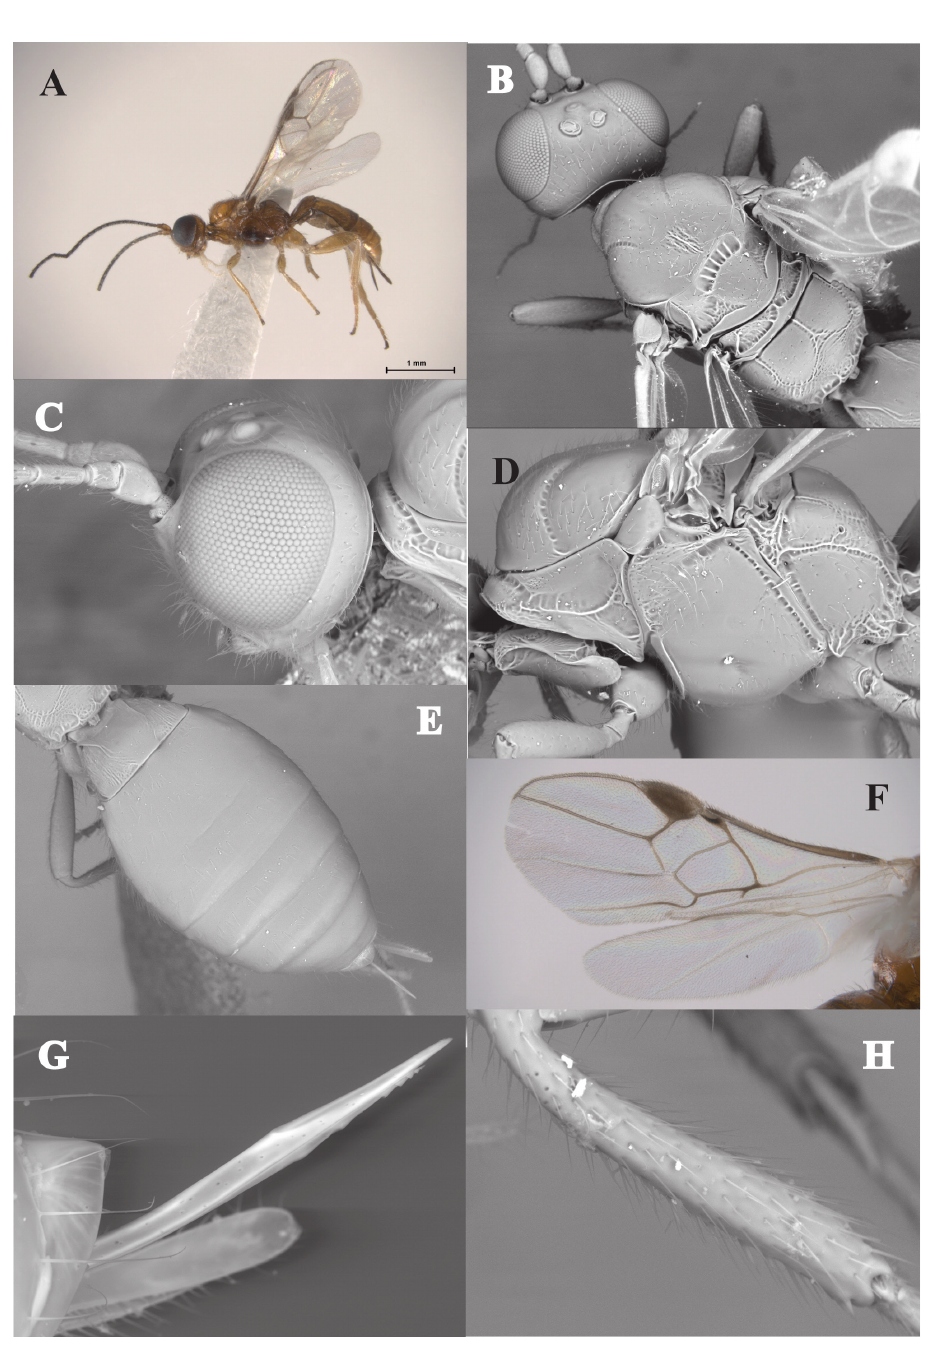
Figure 4. Lissopsius pacificus sp. n. (holotype): A habitus, lateral view B head and mesosoma, dorsal view C head, lateral view D mesosoma, lateral view e metasoma, dorsal view F fore and hind wing G oviposi- tor h fore